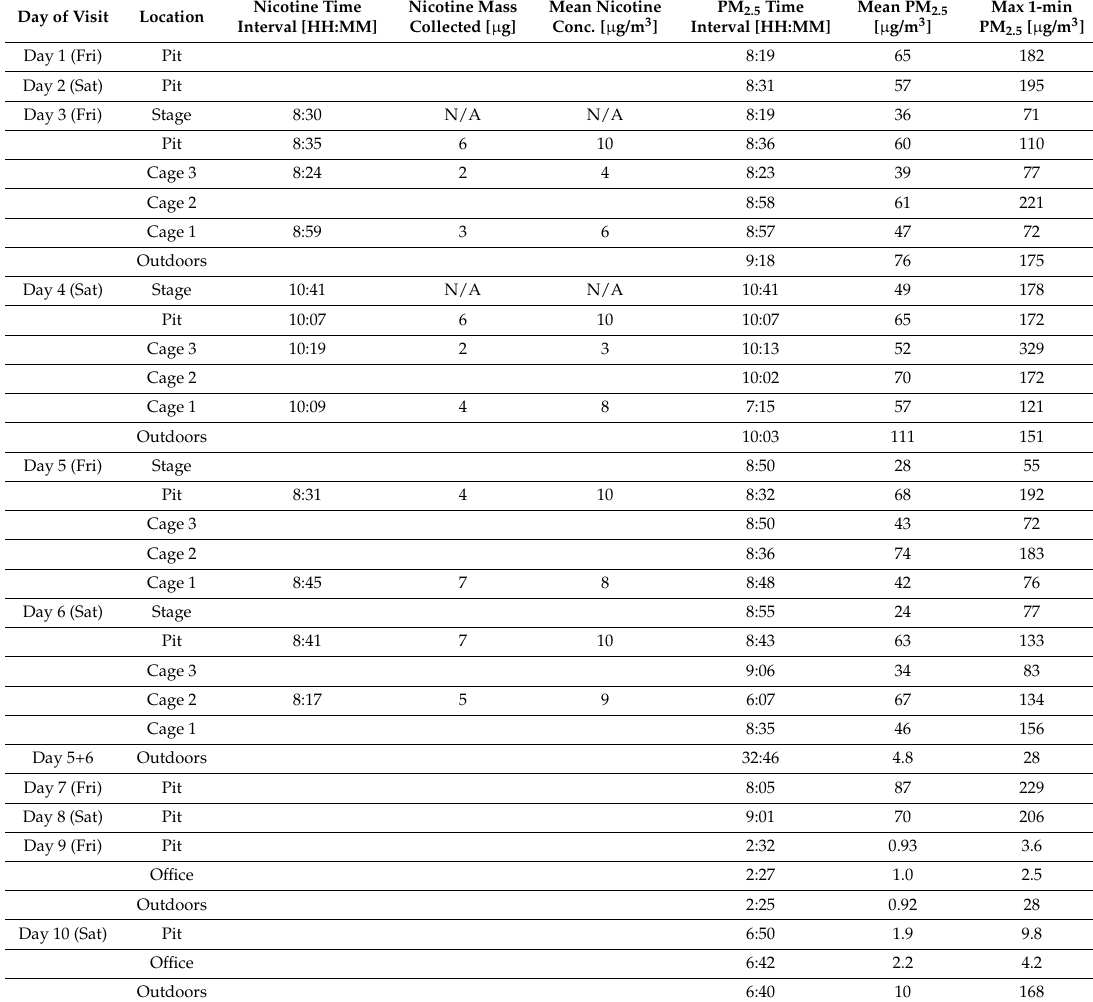
Table S3. Fixed-site airborne nicotine and SidePak-based PM 2.5 concentrations at different Win-River Casino locations by day of visit a